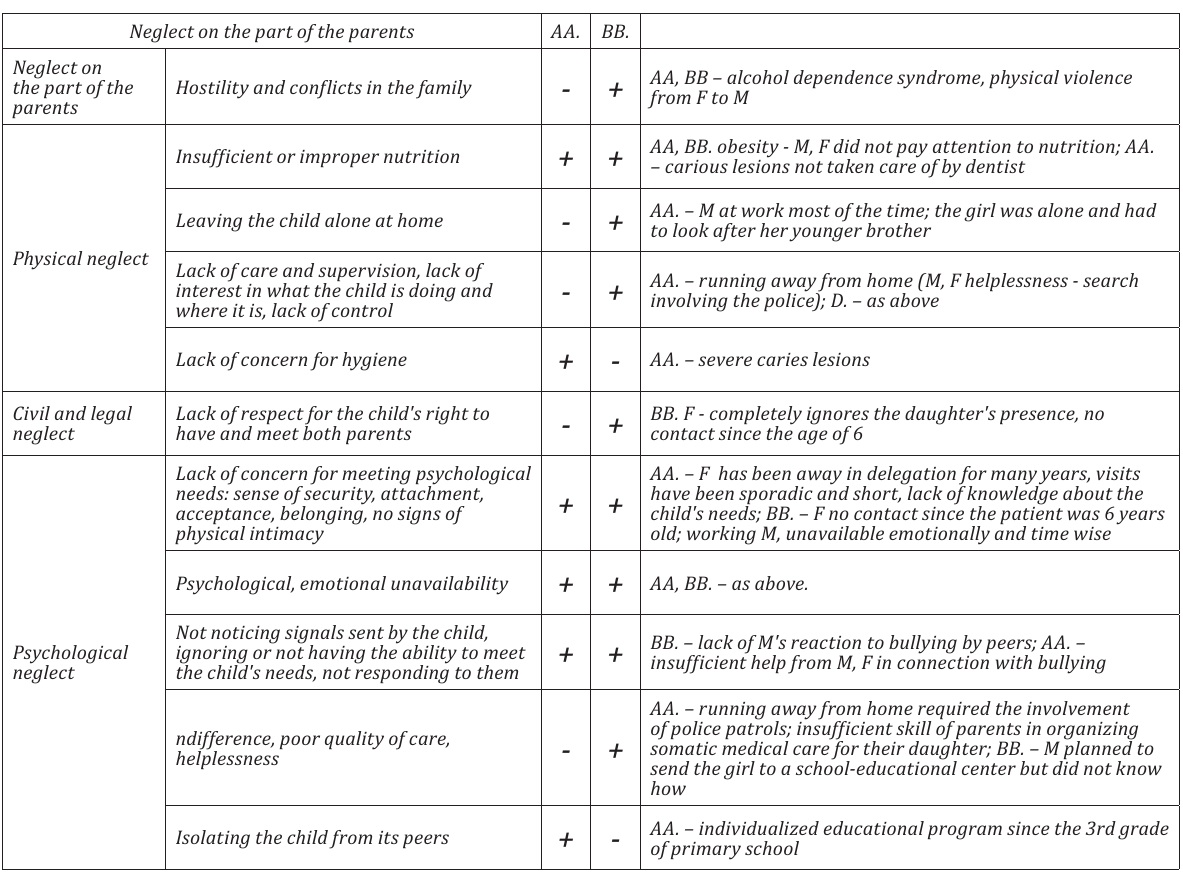
Table 2. Comparison of the neglect experienced by the patients based on literature - M. Kolankiewicz (2012)